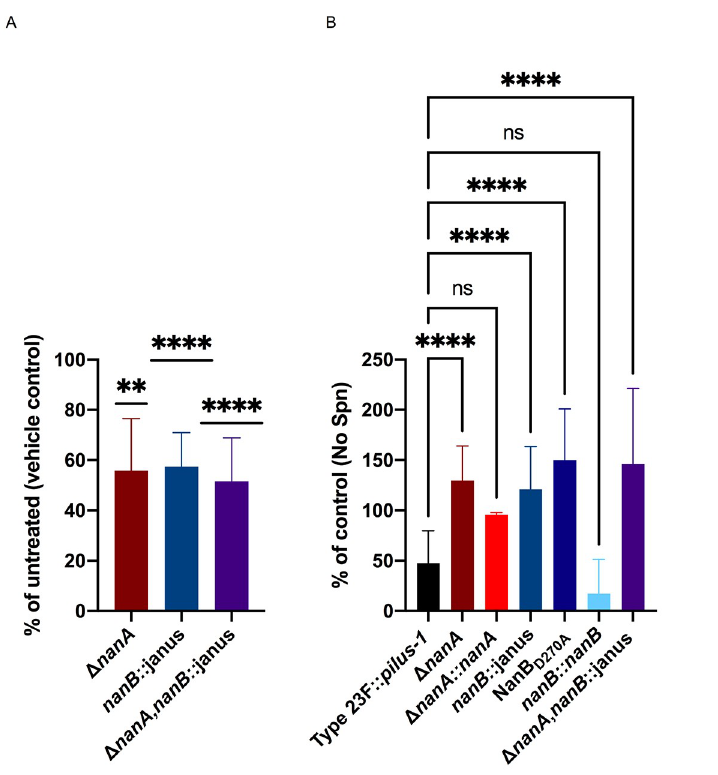
Fig 5. NanB and NanA mediate mucus evasion through removal of sialic acid. (A) Adherence of Type 23F:: pilus-1 and isogenic mutants to pooled human nasal fluid (hNF) was assessed in a solid phase assay. Immobilized hNF (10 μ g) was pre-incubated with exogenous neuraminidase from lyophilized Vibrio cholerae or vehicle control (calcium saline) alone. (B) The ability of Type 23F:: pilus-1 and isogenic mutants to remove sialic acid from mucus was quantified by ELISA. hNF was immobilized in a microtiter plate incubated with bacteria (1 x 10 6 CFU/100 μ l DMEM) for 4hr at 37˚C. Binding of biotinylated lectin Mal-I to α -2,3 sialic acid was detected using peroxidase-coupled streptavidin. The values of control wells without hNF were subtracted from each measured value. Results are illustrated as % of control of untreated hNF. (A-B) Experiments were performed in duplicates and mean values of three independent experiments are shown with error bars corresponding to S.D. �� ,p < 0.01, ��� ; ���� , p < 0.0001. A one sample T test and Wilcoxon test to a theoretical mean of 1 (A) or a one-way ANOVA followed by Dunnett’s multiple comparison test for multiple comparisons were used as statistical tests